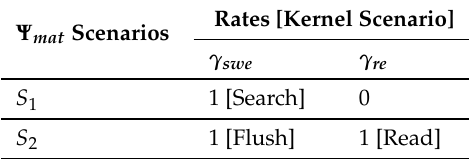
Table 2. MAT d output control channels token rates and scenarios discrimination.